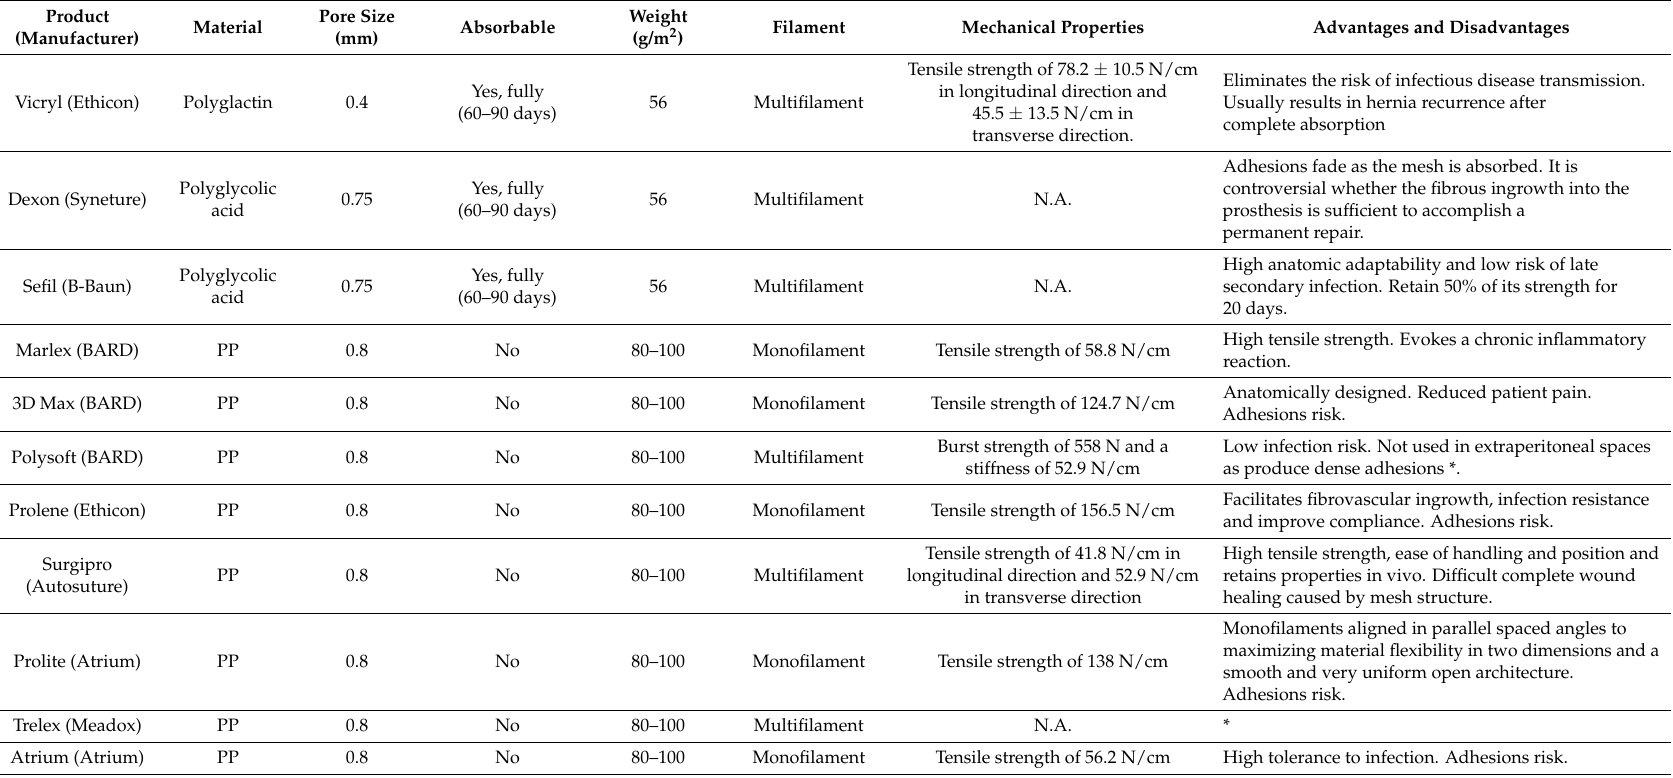
Table 1. Classification of commercially available first generation surgical meshes